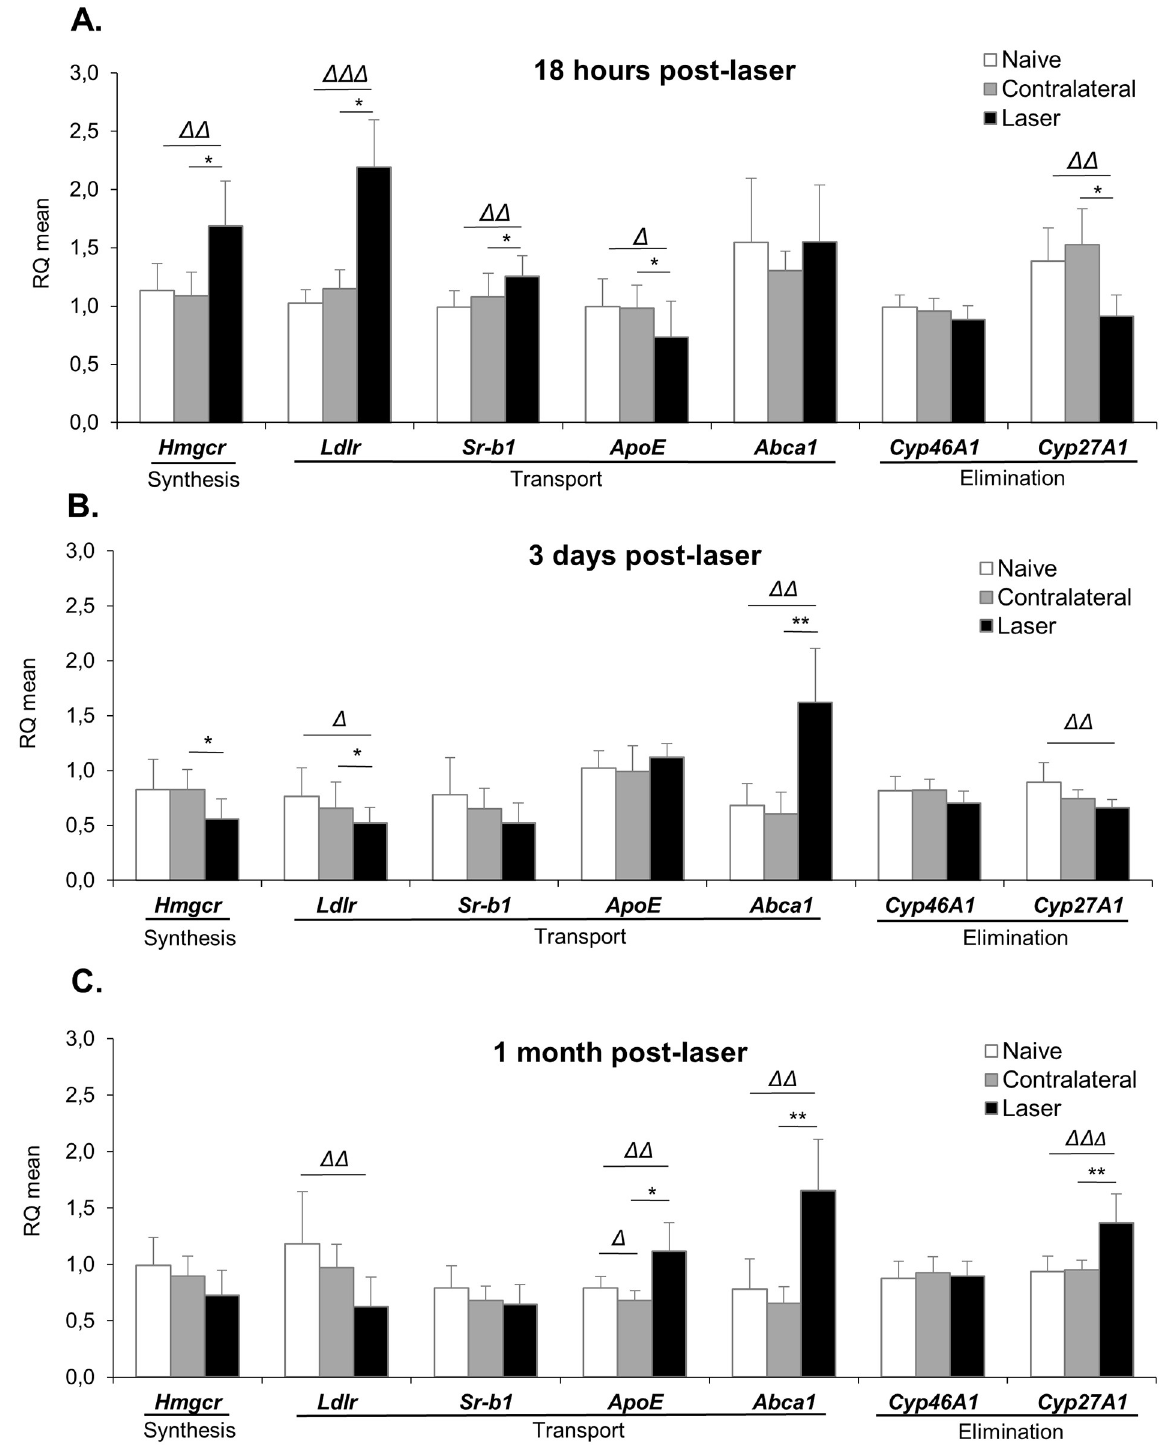
Fig 4. Laser procedure induces dynamic modifications in the expression of genes implicated in cholesterol metabolism. Gene expression was assessed using quantitative RT-PCR on retinas collected at 18 hours (A) , 3 days (B) or 1 month (C) after laser photocoagulation. Data were analysed using the 2 - ΔΔ CT method. Results are presented as mean ± S.D, n = 6–8 retinas. Δ p < 0.05, ΔΔ p < 0.01, ΔΔΔ p < 0.001 vs naive (Mann- Whitney test), � p < 0.05, �� p < 0.01 vs contralateral (Wilcoxon matched-pairs signed rank test).